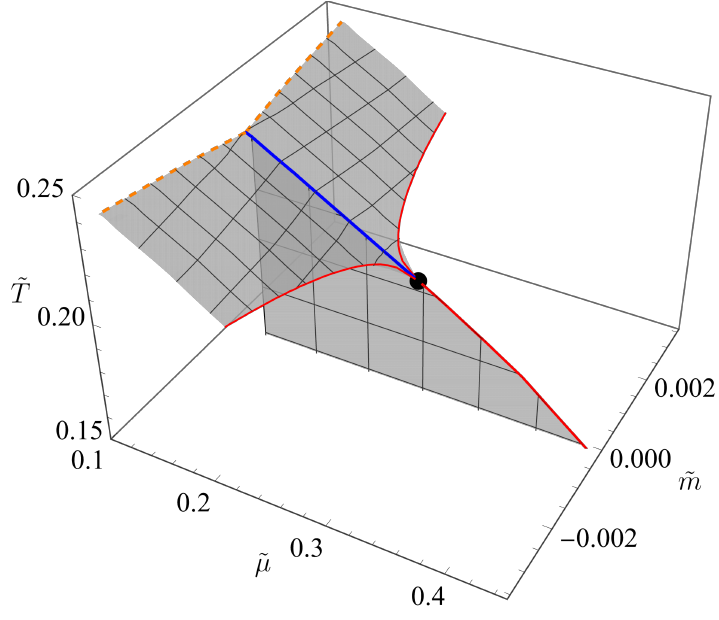
Figure 3 . The three-dimensional phase diagram. The black dot denotes the TCP associated with the chiral transition. The three red solid lines denote the second-order phase transition lines: the λ -line for ˜ m = 0 and two lines of the critical endpoints for ˜ m > 0 and ˜ m < 0 . The blue solid line for ˜ m = 0 denotes the first-order phase transition line, called the triple line. The two orange dashed lines for ˜ m 6 = 0 denote the lines of another critical point associated with the transition between the meson bound state and melted state. The three gray surfaces denote the set of the first-order phase transition